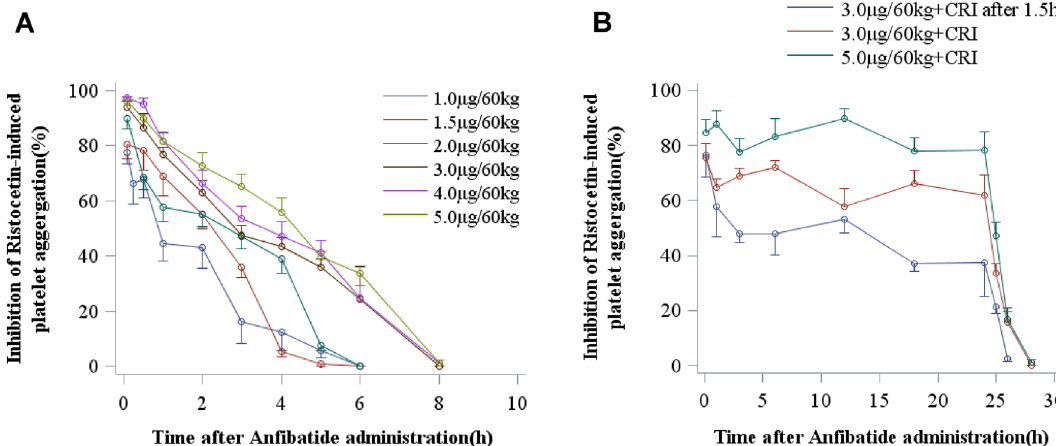
Figure 6. Anfibatide inhibited ristocetin-induced platelet aggregation. Human platelet aggregation induced by ristocetin was studied by platelet aggregometry in single ( A , N = 8–9/each) and multiple dose groups ( B , N = 6–12/each). The mean inhibitory rate of anfibatide on platelet aggregation over time has been shown. CRI, constant rate infusion; Mean ± SEM. Groups Number/group